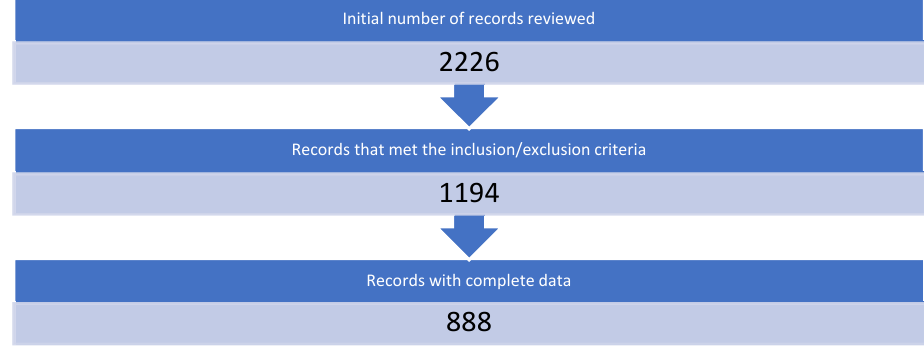
Figure 1. Flow chart of the study participants. Table 1 presents the demographical distribution of the study participants. The data contained an almost equal distribution of males and females (53% and 47%, respectively), with no significant medical history (91%). Based on the patient records, only 20% of the the FBRS). Table 1. Description of the study participants.